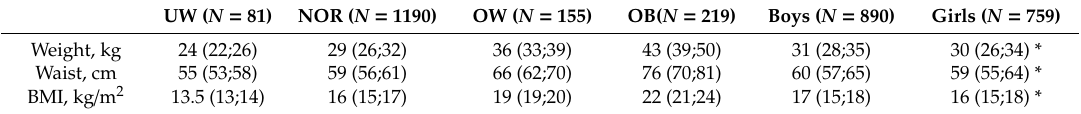
Table 1. General anthropometric characteristics of the study groups and by